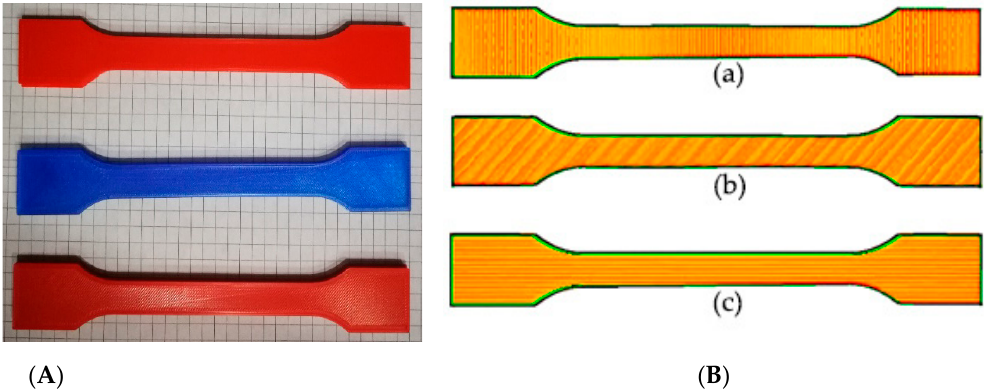
Figure 2. Printed specimens from top to bottom 0 ◦ , 45 ◦ , 90 ◦ , respectively ( A ). Raster angle (infill orientation) of tests specimens: (a) 0 ◦ , (b) 45 ◦ , (c) 90 ◦ ( B ).